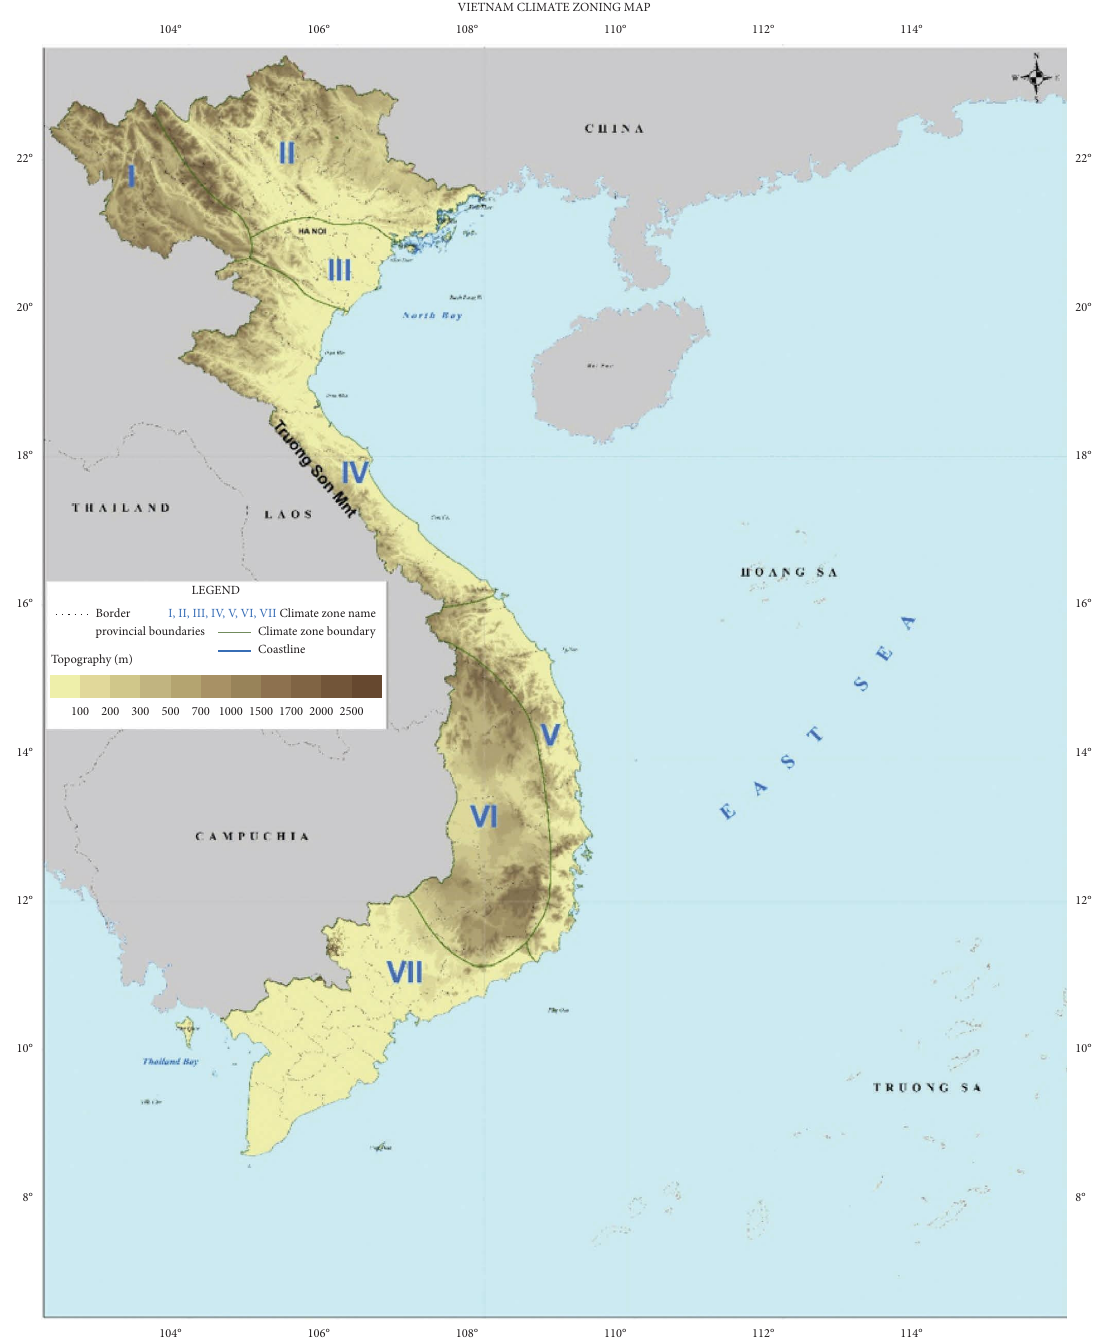
Figure 1: Topography height and seven Vietnam climatic subregions: Northwest (I), Northeast (II), Red River Delta (III), North Central (IV), South Central (V), Central Highland (VI), and Southern Plain